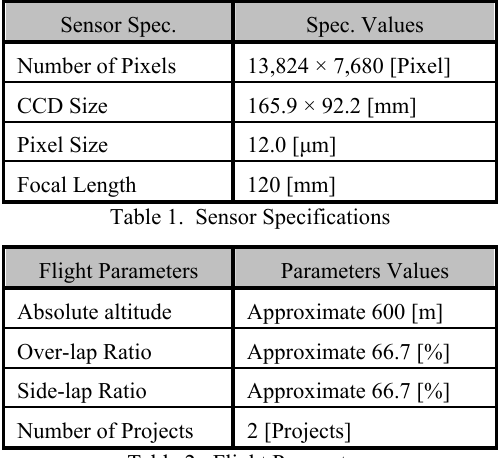
Table 2. Flight Parameters